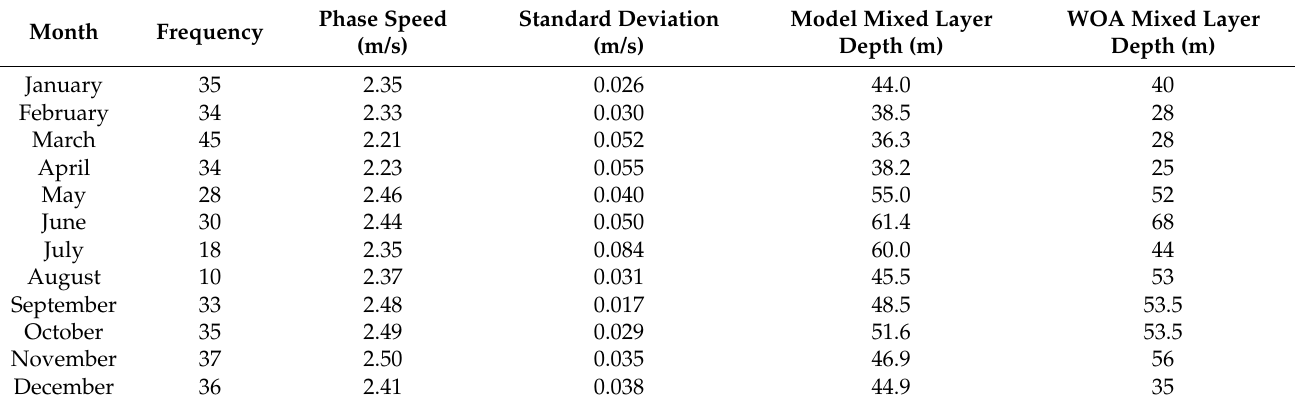
temperature criteria: a temperature change from the ocean surface of 0.5 ◦ C. The same criteria were adopted to evaluate the mixed layer depth from the model results. Table 1. Summary of the statistics for some parameters derived from the numerical model: Monthly averaged (over the 10 years) frequency of events, phase speed and its standard deviation and mixed layer depth. In addition, included is the mixed layer depth from the World Ocean Atlas.